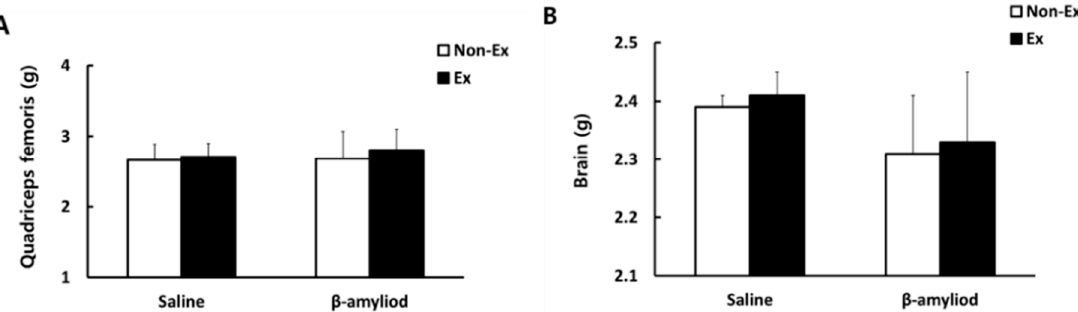
Figure 3. Comparisons of the weight of the quadriceps femoris ( A ) and brain ( B ) after the 12-week intervention.